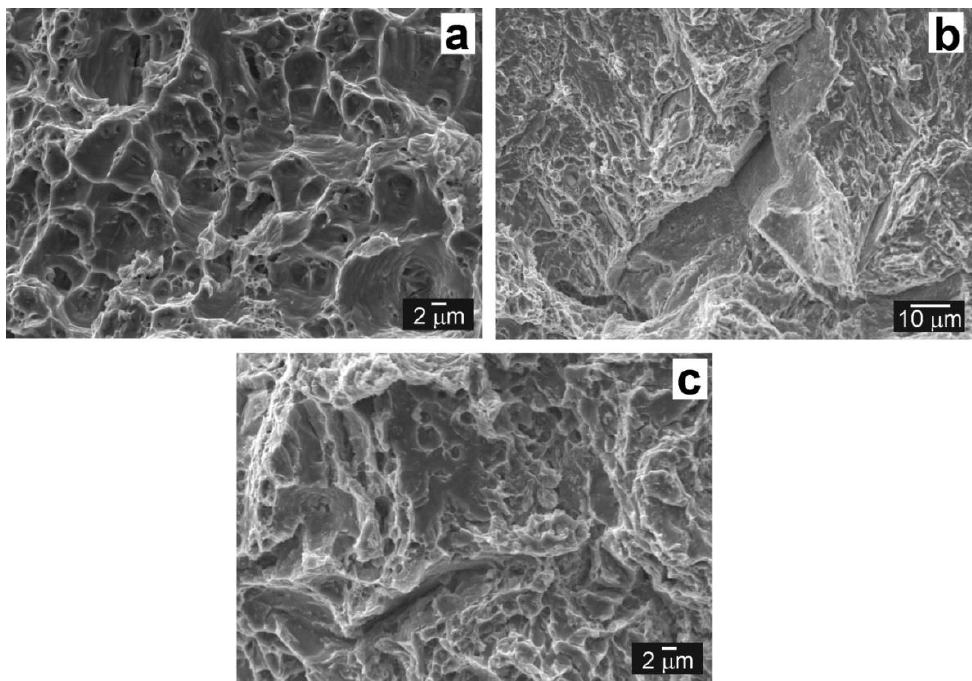
Figure13. Fracturesurfacesoftheagedsamplesfailedafterroom-temperaturetensiletestofT92 / TP316H Figure 13 . Fracture surfaces of the aged samples failed after room-temperature tensile test of dissimilar weldments in fusion zone T92 BM / Ni WM: state QT PWHT + 620 ◦ C / 2500 h ( a ); state QT T92/TP316H dissimilar weldments in fusion zone T92 BM/Ni WM: state QT PWHT + 620 °C/2500 h PWHT + 620 ◦ C / 2500 h + H ( b ); and its detailed view ( c ( a ); state QT PWHT + 620 °C/2500 h + H ( b ); and its detailed view ( c ).